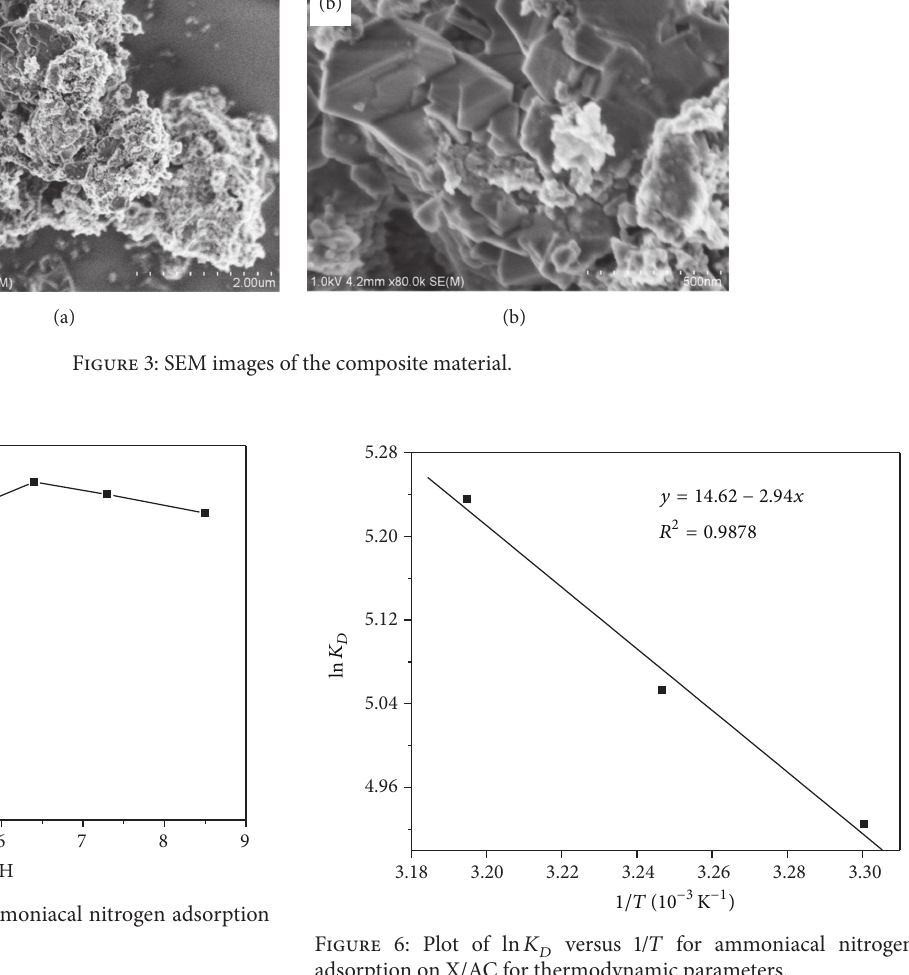
Figure 6: Plot of ln 𝐾 𝐷 versus 1/ 𝑇 for ammoniacal nitrogen adsorption on X/AC for thermodynamic